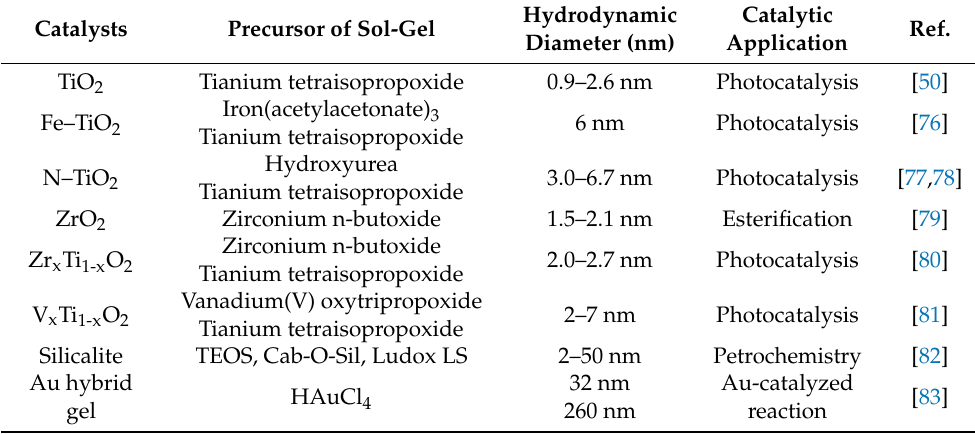
Table 6. Hydrodynamic diameter of different catalysts determined by in situ